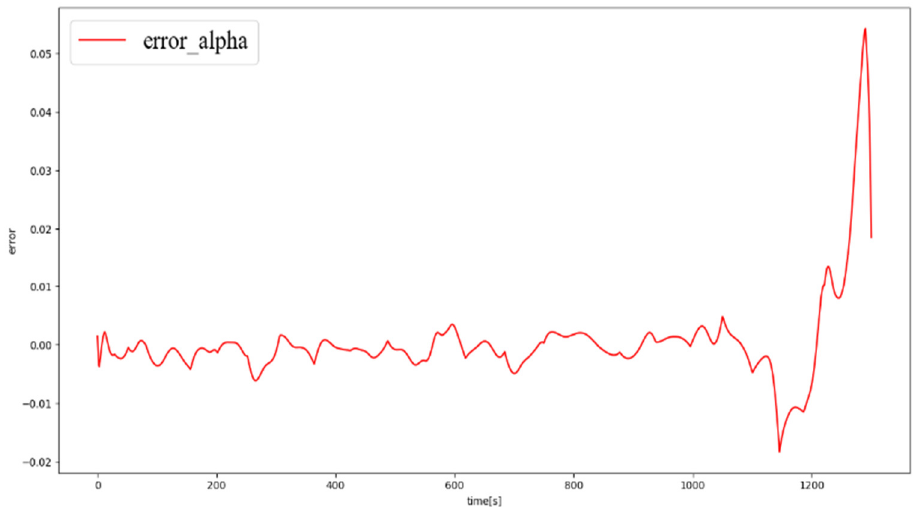
Figure 10. Generalized lift error change with time.